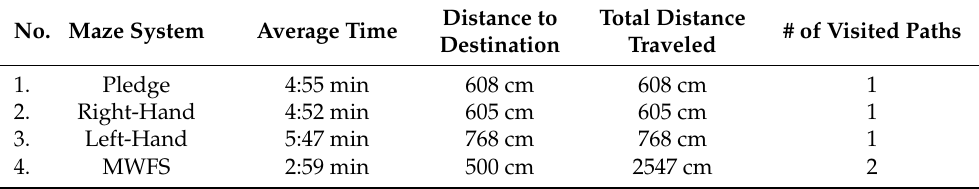
Table 8. Experimental results obtained from the third experiment testbed.